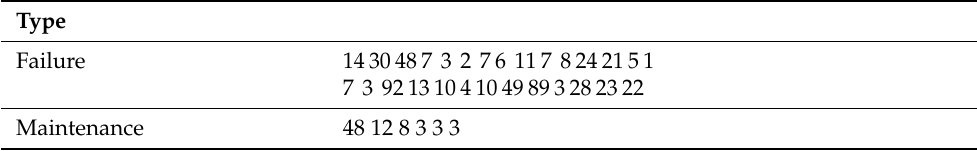
Table 3. Pump data: failure and maintenance